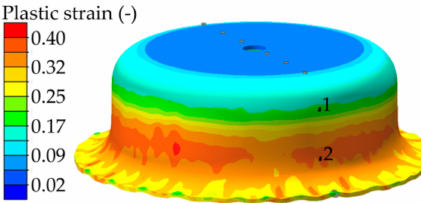
Figure 12. FE-simulation for the distribution of the plastic strain in a thermomechanically treated cup of X46Cr13 after austenitization at 1050 ◦ C for 300 s and subsequent start of forming at 900 ◦